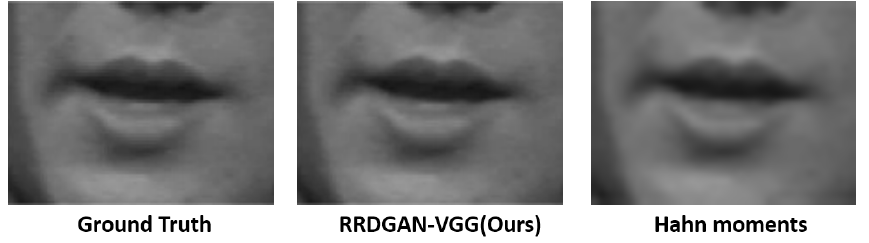
Figure 21. Comparing the super-resolution part of our method with Hahn moments using